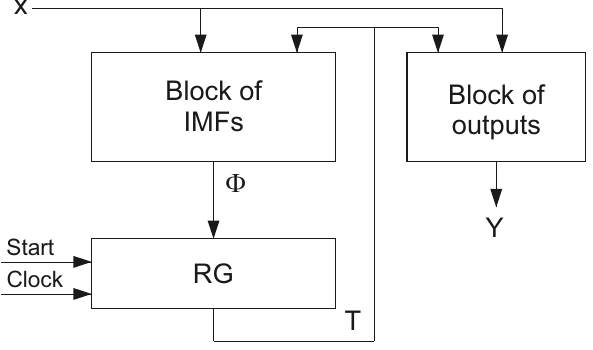
Figure 1. Structural diagram of P Mealy